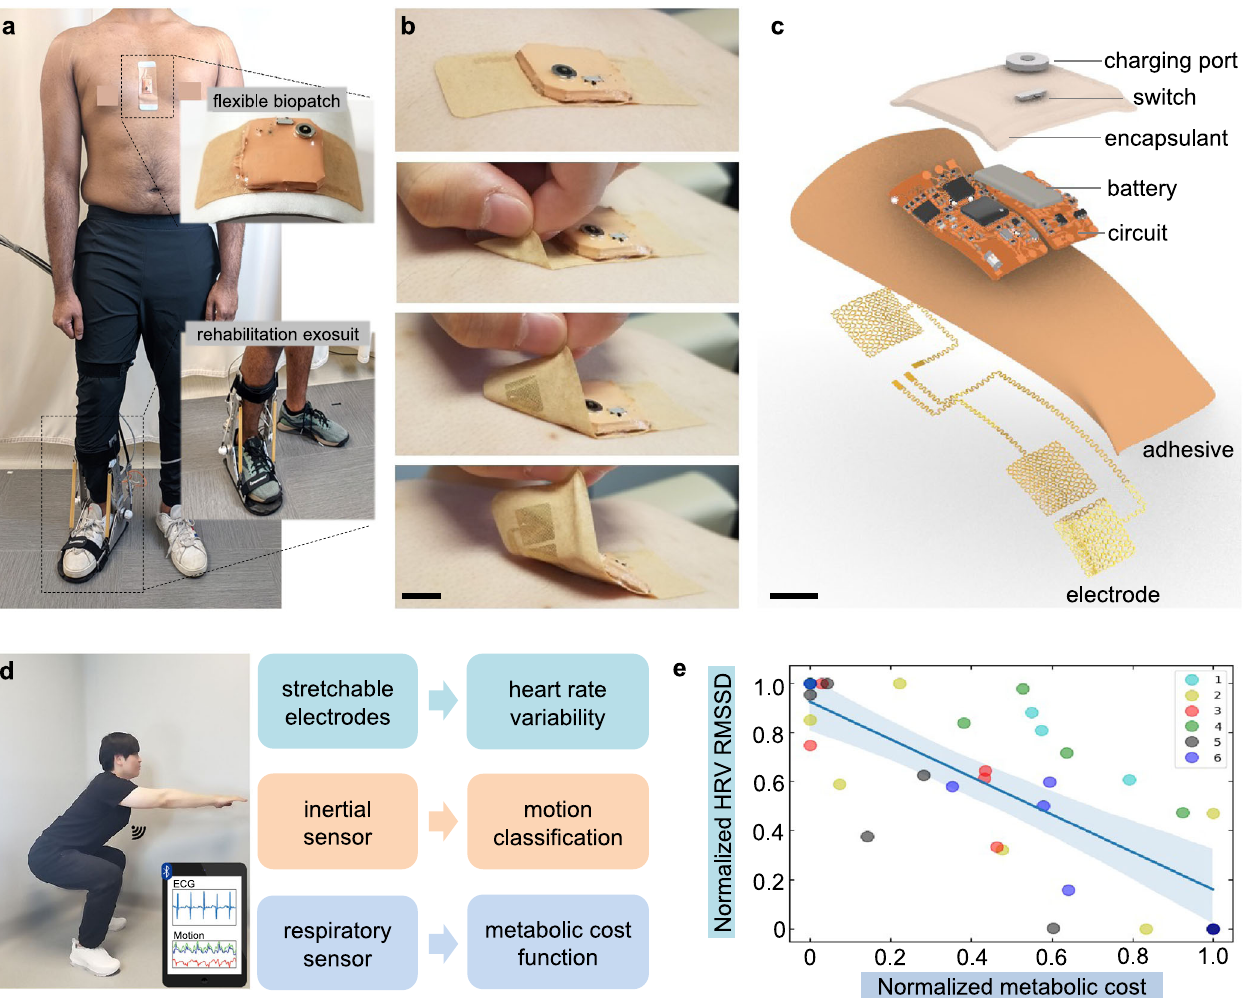
Fig. 1 Overview of a soft fl exible bioelectronic system (SFB) integrated with an ankle-foot-orthosis (AFO) exoskeleton to estimate metabolic costs and physical effort. a Photo of a subject wearing an SFB and an AFO. b A series of photos of the skin-mounted SFB showing conformal lamination and soft contact to the skin. Scale bar: 1 cm. c Rendering image of an exploded view of the SFB with integrated components. Scale bar: 1 cm. d Photo of a subject who is squatting (left) and a list of wireless wearable sensors in the SFB with measurable physiological data. e Plot showing the relationship between normalized HRV-RMSSD from the SFB and normalized metabolic cost from a calorimetric respiratory